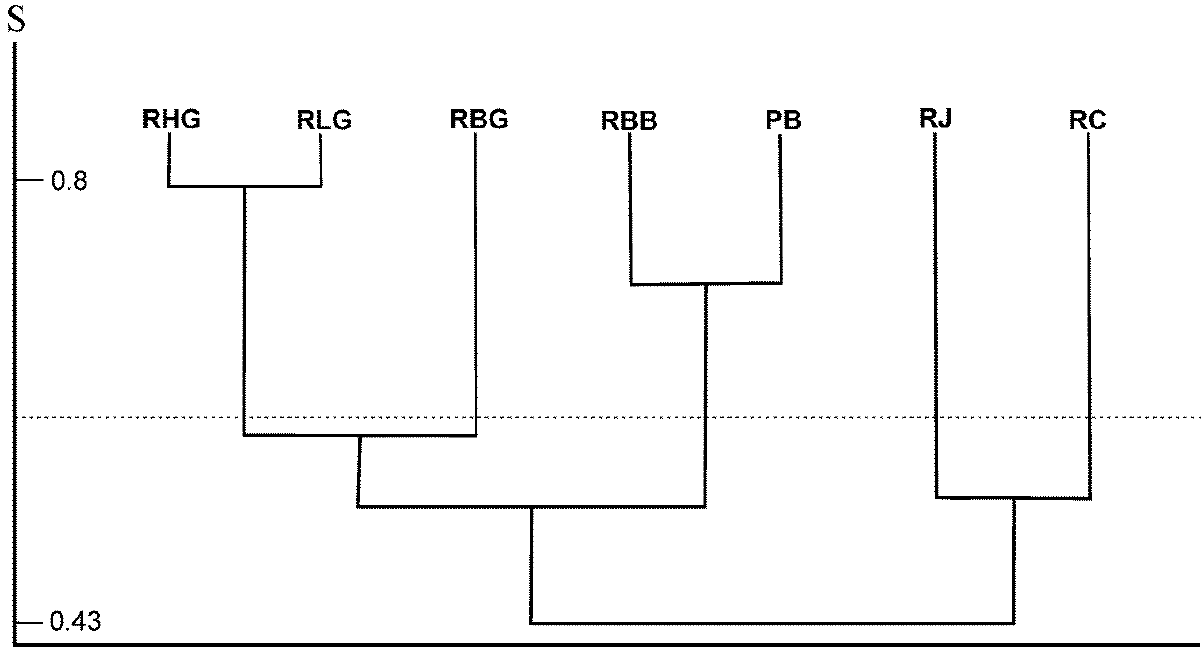
Figure 2. Species similarity (S) of the species composition in Uropodina communities in examined locations: PB—Białowie˙za Primeval Forest, RC—Cisy Staropolskie im. Leona Wycz ó łkowskiego Nature Reserve, RJ—Jakubowo Nature Reserve, RLG—Las Gr ˛adowy near Mogilnica Nature Reserve, RBB—Byty´nskie Brz˛eki Nature Reserve, RBG—Brz˛eki near Stara Gaj ó wka Nature Reserve, RHG—Huby Grzebieniskie Nature